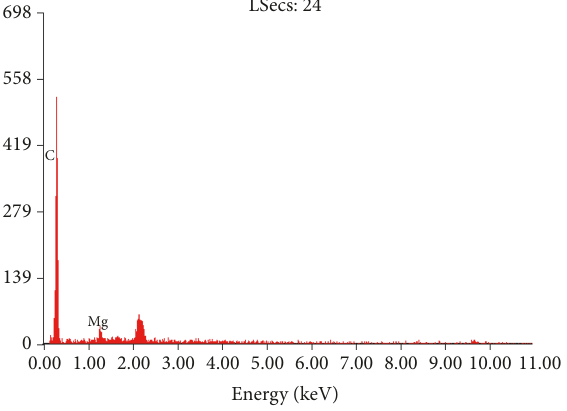
Figure 9: EDS analysis of the matrix damage crack.